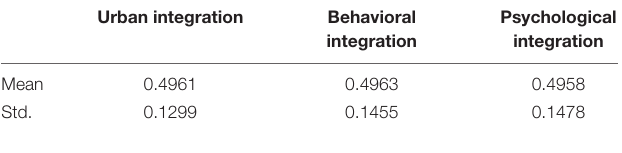
TABLE 4 | The statistical description of migrant workers’ urban integration.